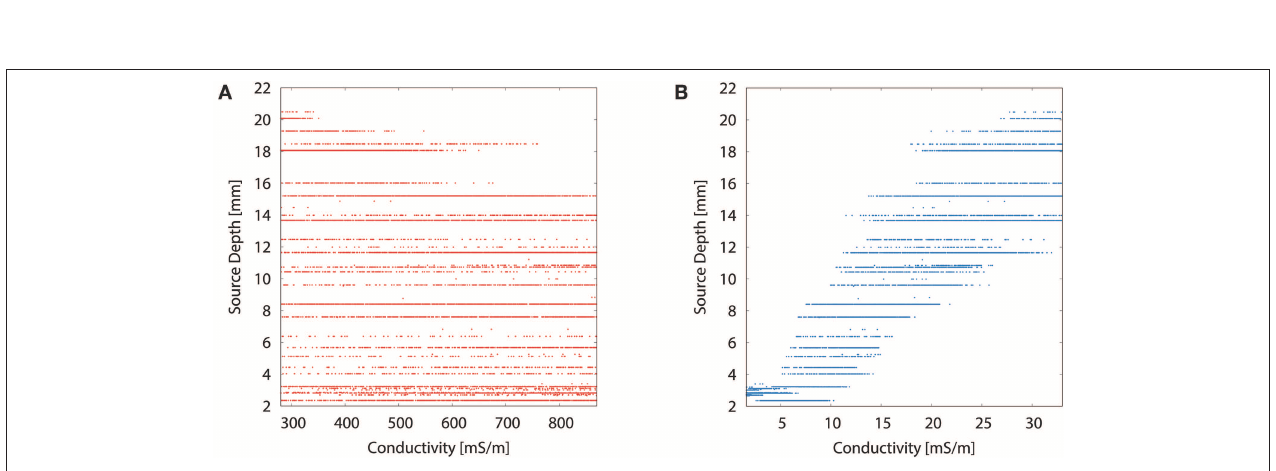
FIGURE 8 | Scatter plots of source depth as a function of the tissue conductivity for the multivariate distribution for skin (A) and skull (B)